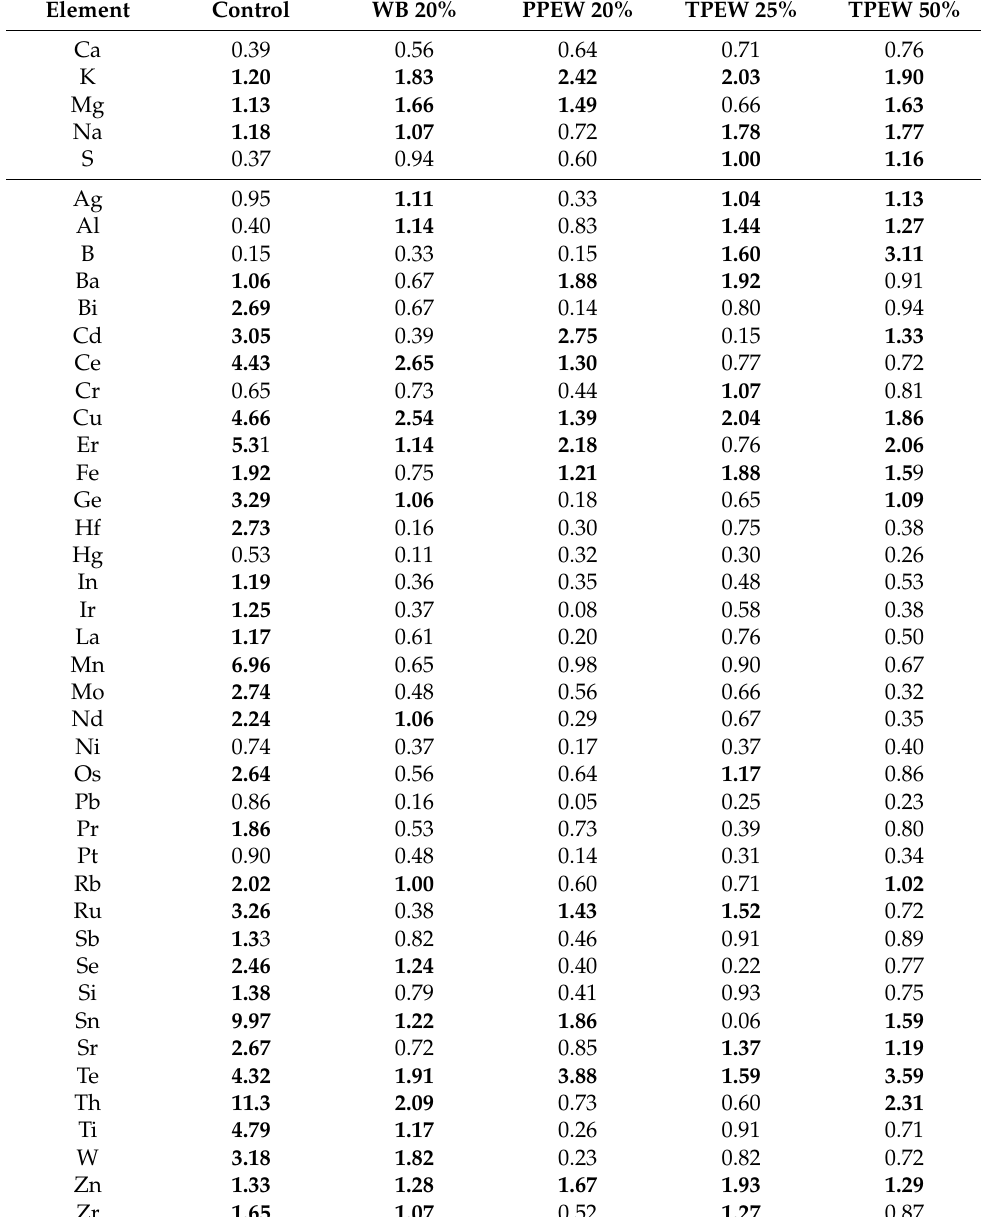
Table 1. Bioconcentration factor (BCF) values calculated for Pleurotus citrinopileatus growing at particular